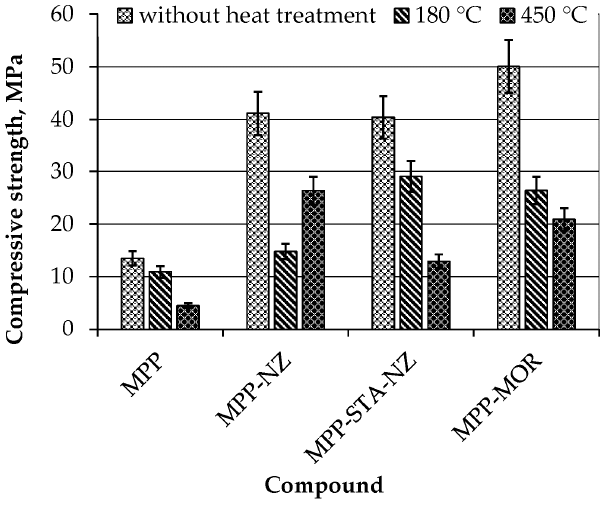
Figure 5. Compressive strength of the MPP compounds.